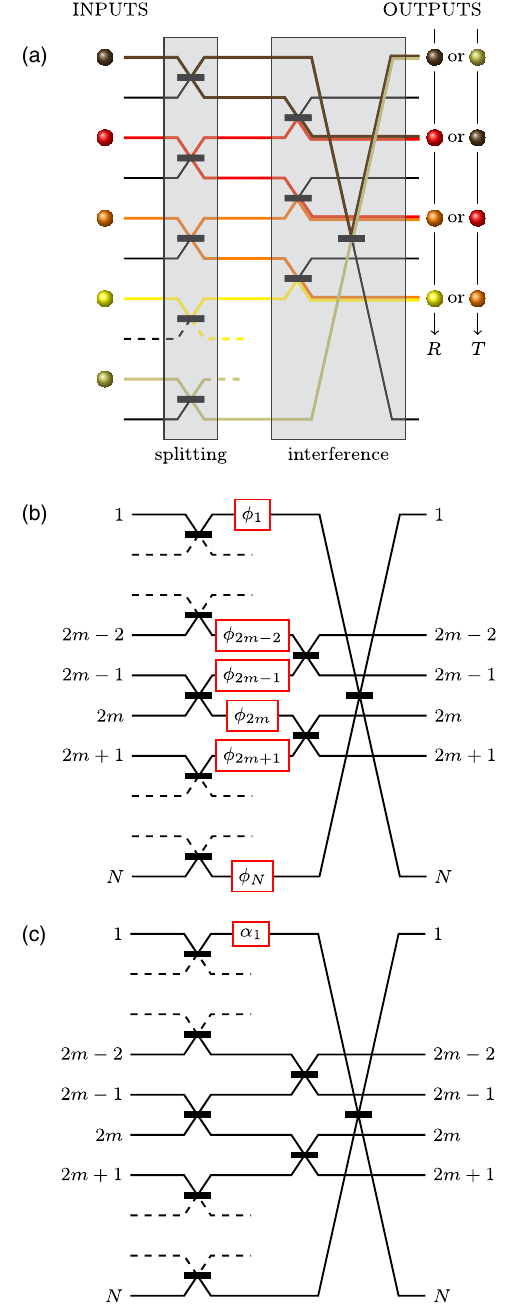
FIG. 1. (a) Conceptual scheme of the interference process. The cyclic interferometer consists of two cascaded layers of balanced beam splitters. If we inject one photon per pair of adjacent input modes, the first beam splitter layer branches the input state into two alternativepaths(reflected R andtransmitted T ).Pathsareinterfered pairwise at the second layer, employing a cyclic layout. (b) In most general terms, the phase delays that are physically introduced by the optical propagation on the internal arms of the interferometers can be described by phase terms ϕ . (c) Schematic representation of an i interferometer equivalent to the one shown in (b), where the many phase shifts ϕ are replaced by a single element α 1 on the first arm, i with phase delays considered as null in the other